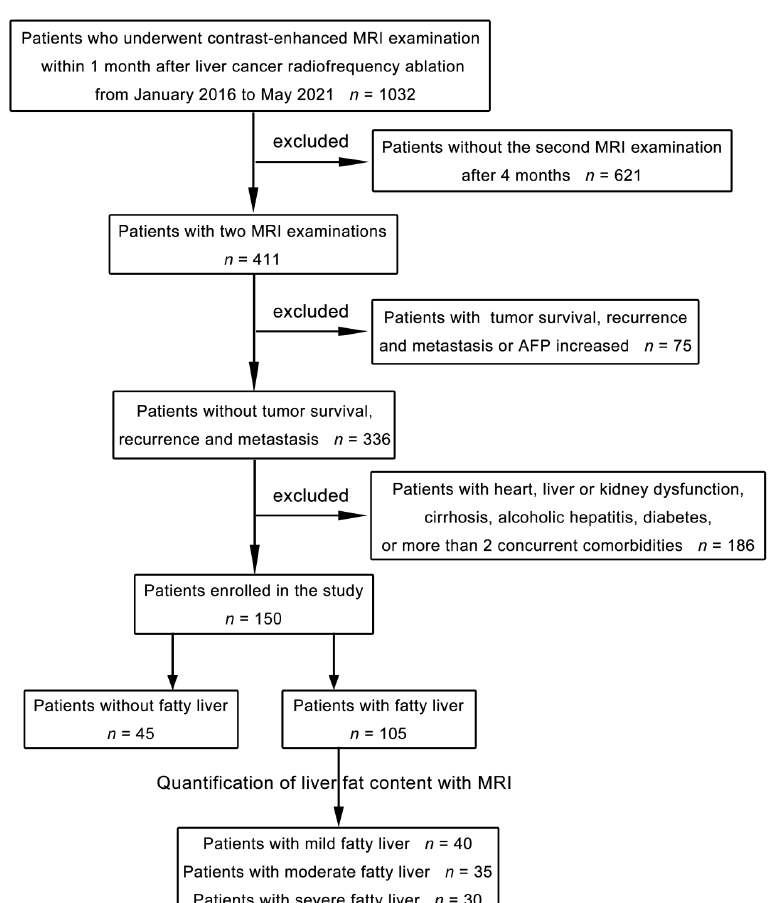
Figure 1. Flowchart of the patient selection process. Table 1. Clinical data of all patients.